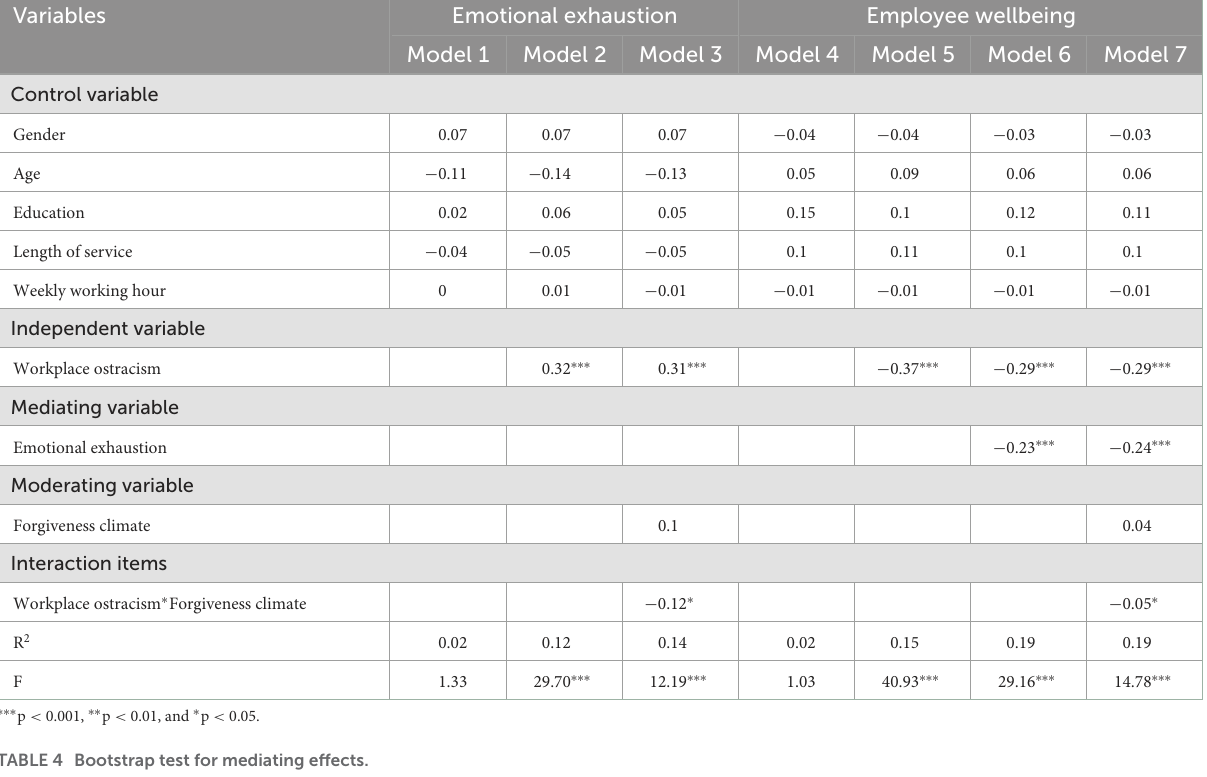
TABLE 3 Hypothesis testing model.